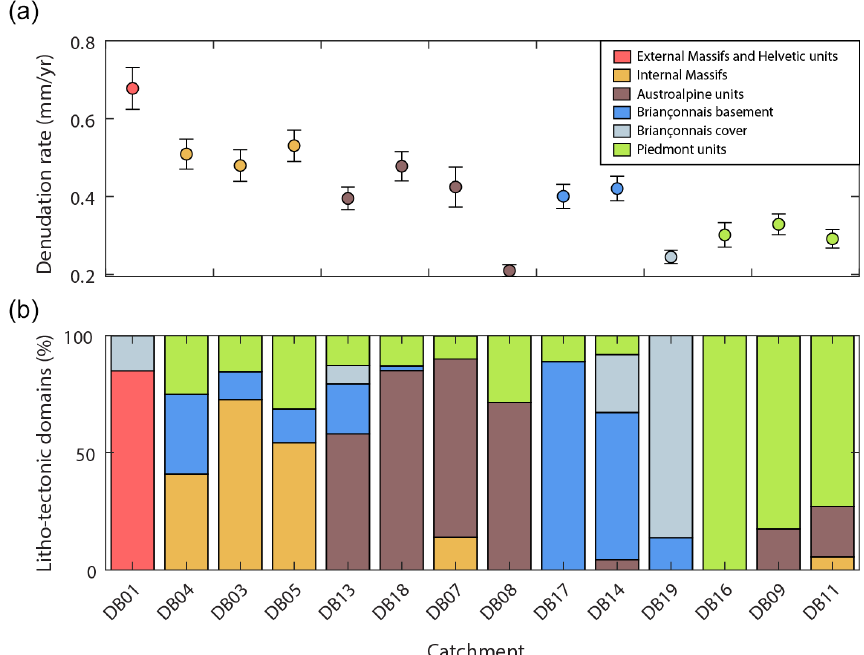
Figure 6. Tributary–catchment denudation rates (a) and relative proportion of lithotectonic units within the quartz-bearing areas of the individual catchments (b) . Colour code in panel (a) refers to the most abundant lithotectonic unit in each individual catchment (see Fig. 2 for spatial distribution of the different lithotectonic